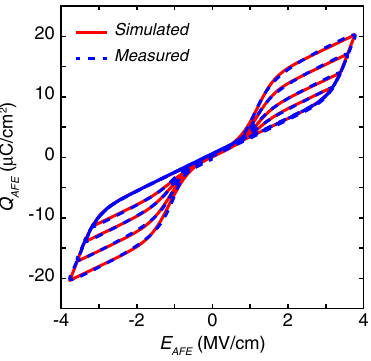
Figure 5. Experimental data from a 10 nm ZrO 2 sample in excellent agreement with the antiferroelectric model for both saturated and unsaturated double hysteresis loops. The extracted P s + , P r + , E c + , E c , shift + , P s − , P r − , E c − , E c , shift − , P offset , and ε AFE are 6.40 μC/cm 2 , 6.34 μC/cm 2 , 1.12 MV/cm, 2.39 MV/cm, − 6.61 μC/cm 2 , − 6.51